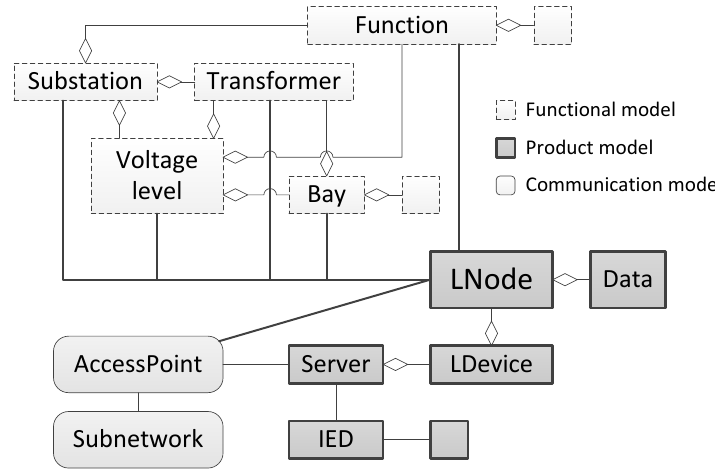
Figure 3. Main modeling objects as defined in IEC 61850-6, based on